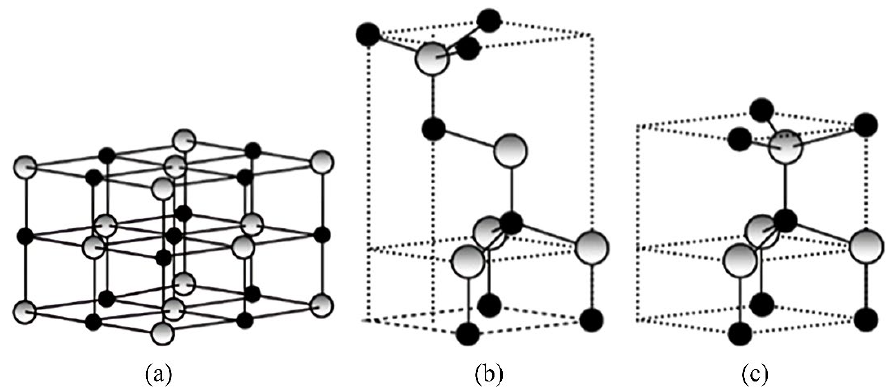
Figure 6. Crystal structures of ZnO: ( a ) rocksalt, ( b ) zinc blende, and ( c ) wurtzite. Reproduced with permission from [178].